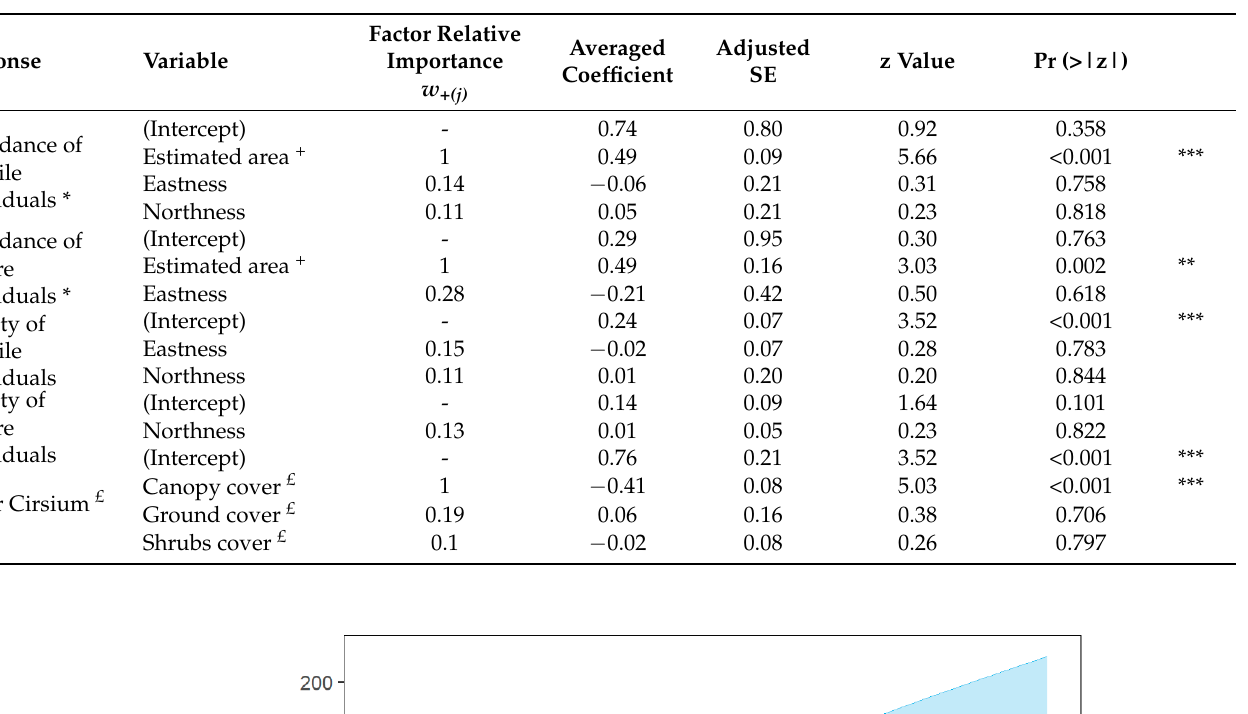
Table 2. The multimodelling on GLM on the factor affecting mature and juvenile individuals abundance and density, and on Cirsium alpis-lunae cover at the subplot level. Averaged coefficients are provided only for factors included in the set of best models (see supplementary materials for full model selection tables). A ( + ) marks the log-transformed variables in the following analyses, while a £ marks those transformed with an arcsin transformation. Significance codes: p < 0.001 = ***; p < 0.01 = **; p < 0.05 = *.